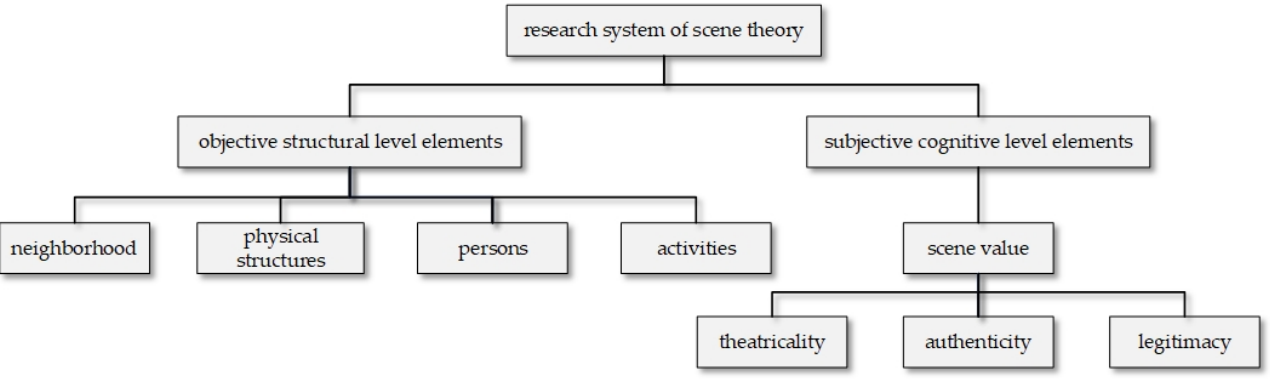
Figure 1. The research system of scene theory